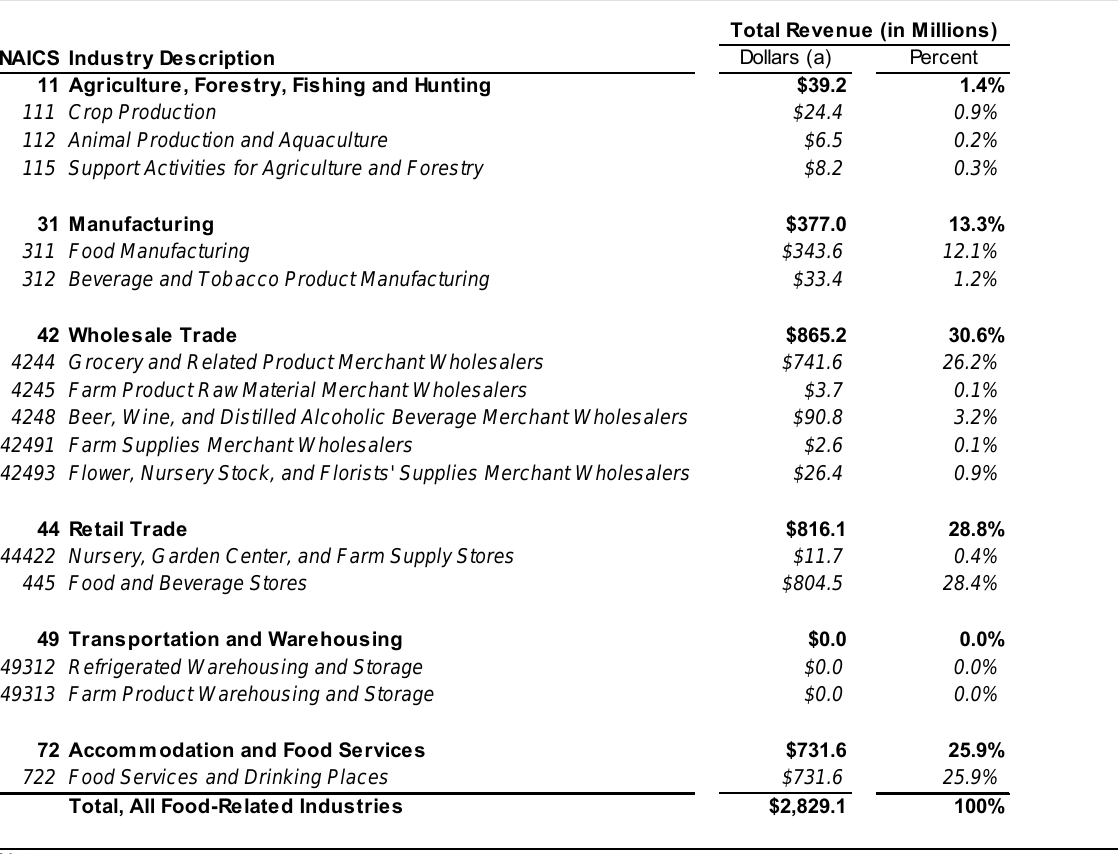
Reprinted from SAGE, 2016, Table 3.5; used with